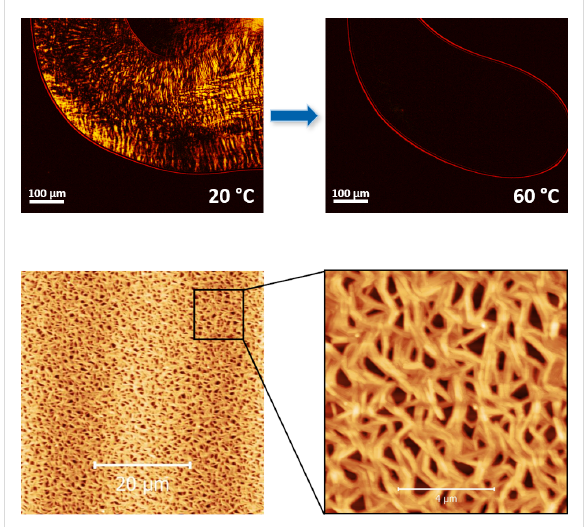
Figure 8: Polarized optical microscopy (POM) images of the 2 /toluene system (5 wt %) with crossed polarizers (10-fold magnification) at ambient temperature and after heating to 60 °C (upper panel), and atomic force microscopy (AFM) height images of 2 /toluene (50 µM, lower